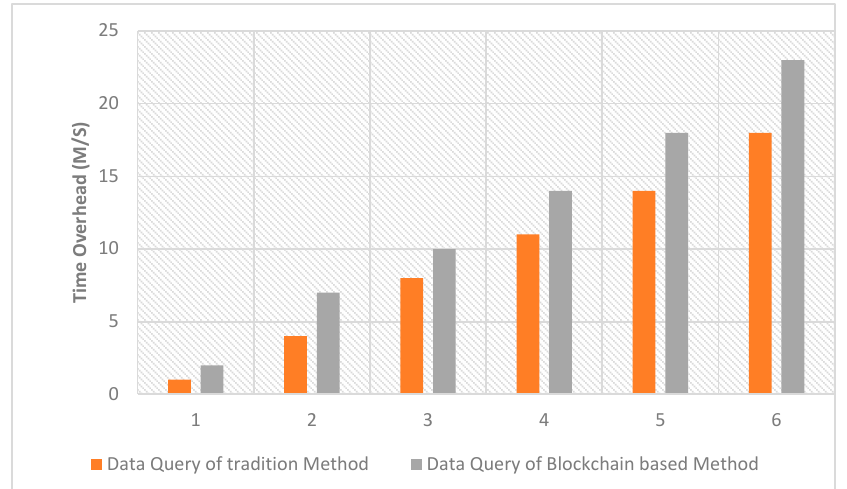
Figure 7. Comparison of Access Control .